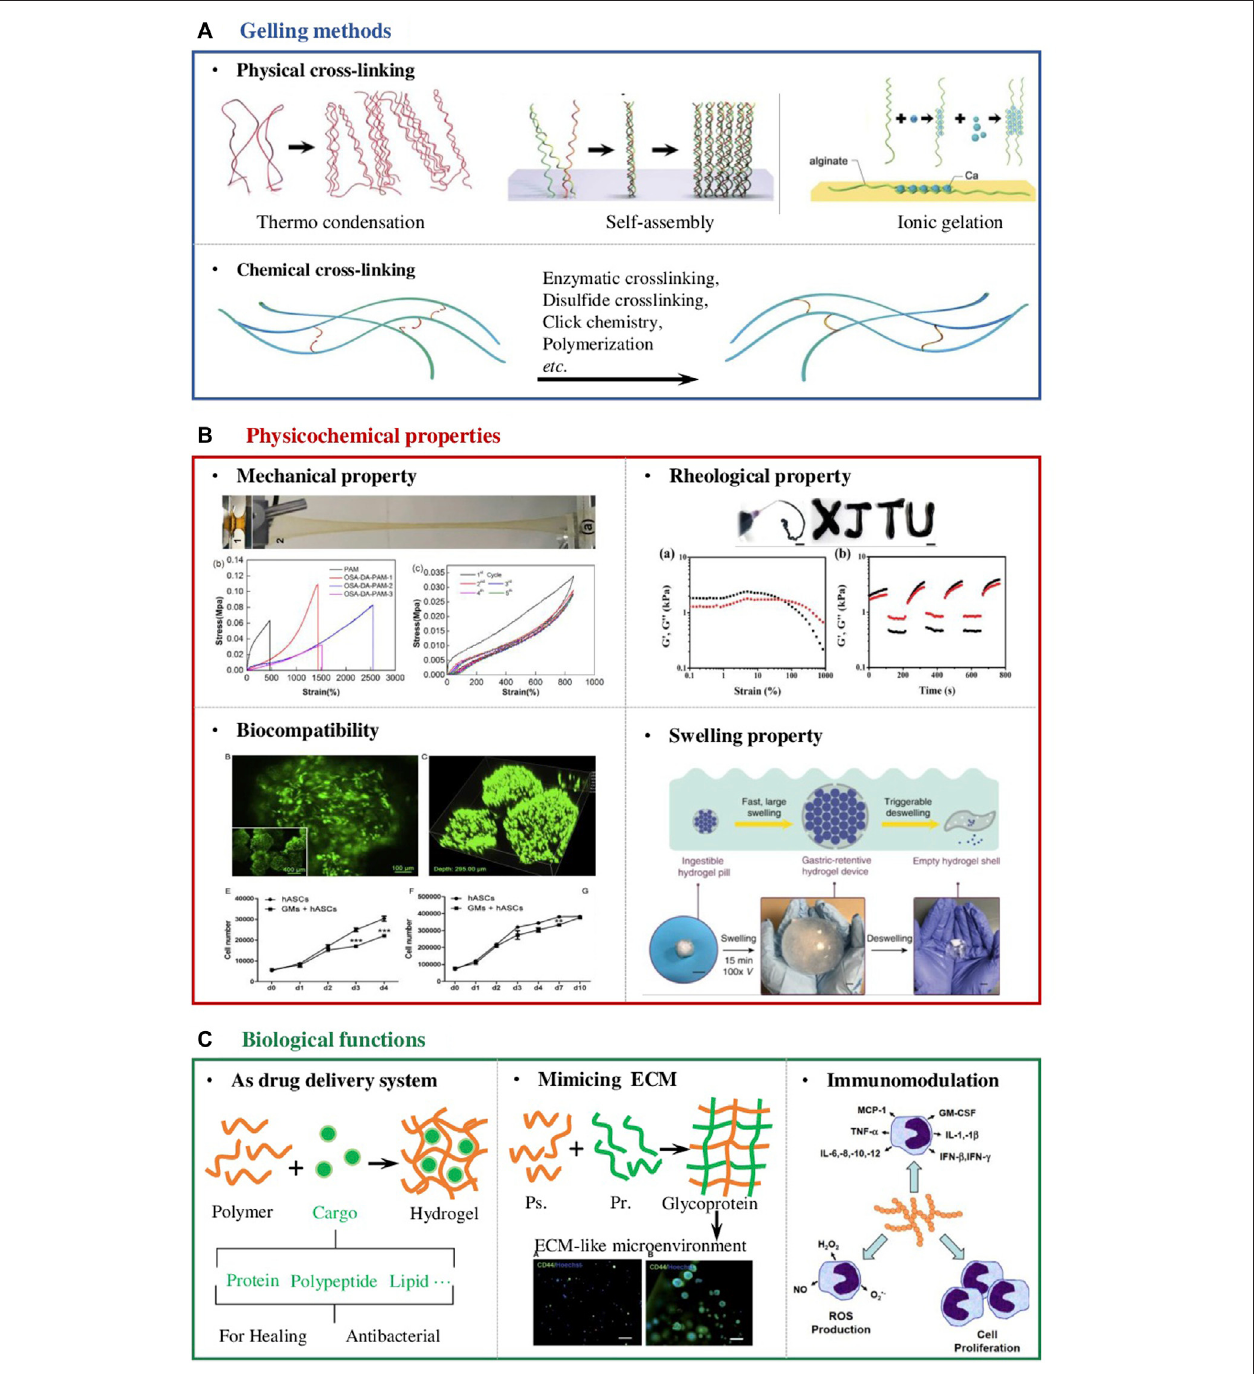
FIGURE 1 | Design considerations of polysaccharide-based hydrogel wound dressings. (A) Schematic diagram of the two main cross-linking methods of polysaccharide-based hydrogels, namely physical and chemical cross-linking (Zhang and Khademhosseini, 2017) (B) The physicochemical properties that should be considered in the design of hydrogel wound dressings include but are not limited to mechanical properties (Chen et al., 2018), rheological properties (Zhao et al., 2020), biocompatibility(Zeng etal.,2015)andswellingproperties(Zhuetal.,2019). (C) Theuniquebiologicalproperties ofthepolysaccharide-based hydrogelenableitto manage wounds; Firstly, they can serve as a drug delivery system to deliver antibacterial agents, growth factors, stem cells and so on. Secondly, polysaccharide moleculesarethemaincomponentsoftheextracellularmatrix(ECM)(Bystro ň ováetal.,2018).Whendesigningwounddressing,theycanbecompoundedwithproteins to form glycoproteins to provide cells in the wound with a microenvironment similar to the ECM. In addition, polysaccharide molecules themselves can participate in the immune modulation process in the body, so designing a hydrogel with an appropriate degradation rate can promote wound healing from the perspective of immune regulation (Schepetkin & Quinn, 2006; Shah et al., 2021).